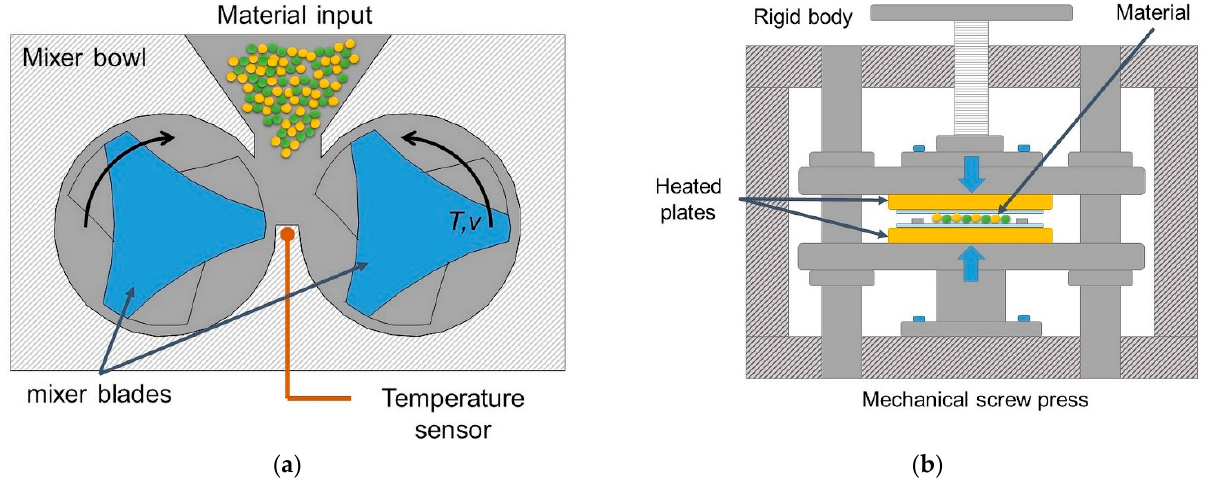
Figure 4. Schemes of ASR polymer composite preparation: ( a ) internal mixer; ( b ) hot pressing process.